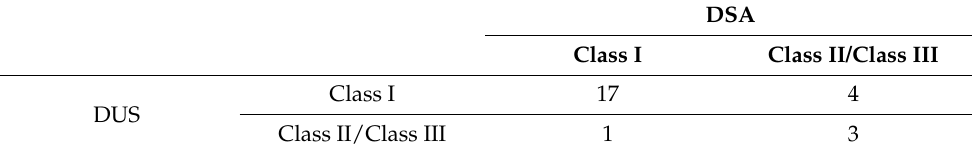
Table 2. Cross modality comparison between DUS and DSA in diagnosing aneurysm reperfusion.